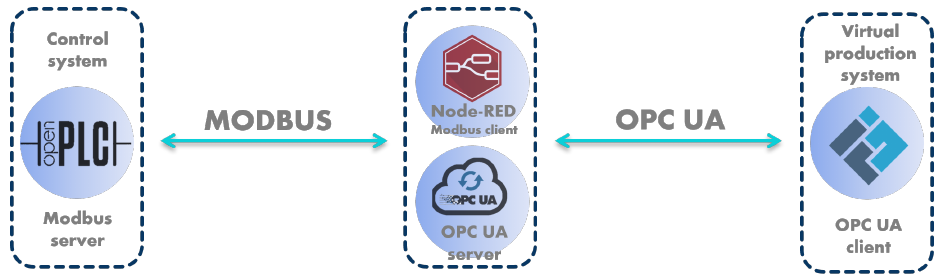
Figure 24. OpenPLC linked with Node-RED acting as a software IIoT